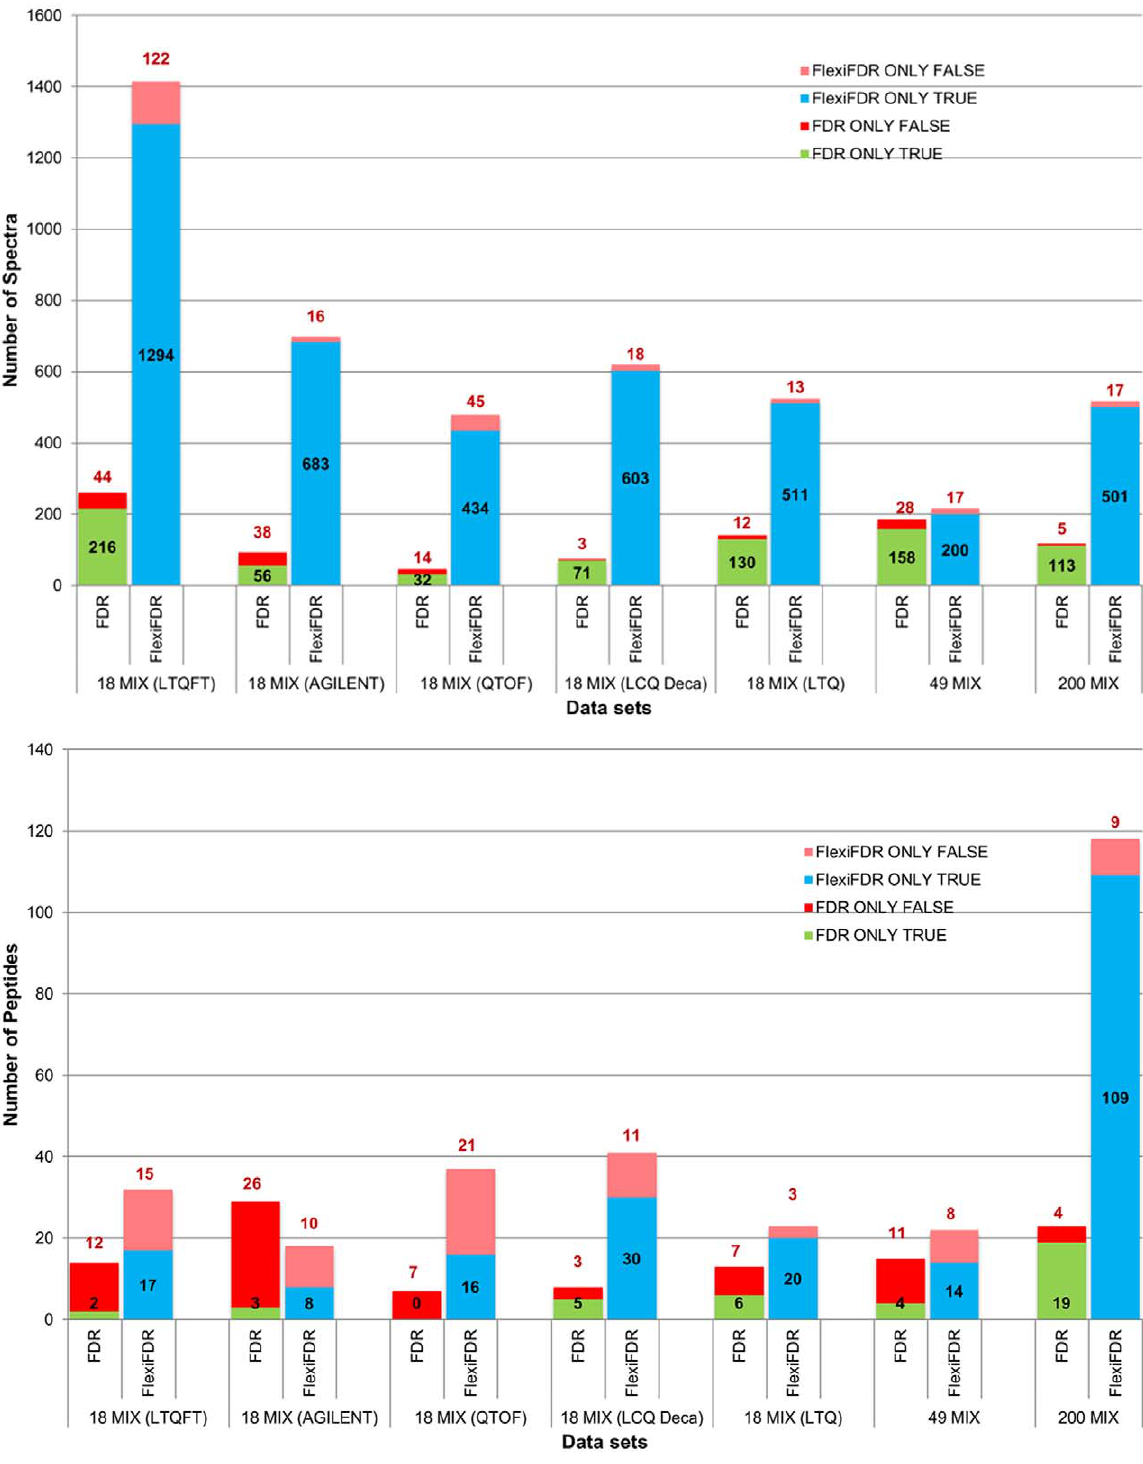
Figure 4. Comparison of unique identifications (spectra and peptides) from concatenated search. Top and Bottom panels depict spectra and corresponding peptide comparison from a concatenated search. The blue colored bars represent the unique true hits added by FlexiFDR alone while green colored bars represent unique true hits from FDR alone. Similarly, the pink bars denote false hits from FlexiFDR alone while red bars denote false hits from FDR alone. The spectral hits from FDR can be mapped to unique peptides right in the lower panel. The false spectral hits in case of FDR alone bring more false peptide identifications than FlexiFDR (compare bars from A to B vertically). FlexiFDR brings more unique true hits than FDR and brings lesser number of unique false hits. This enhances the true positives and decreases false positives in the datasets shown.